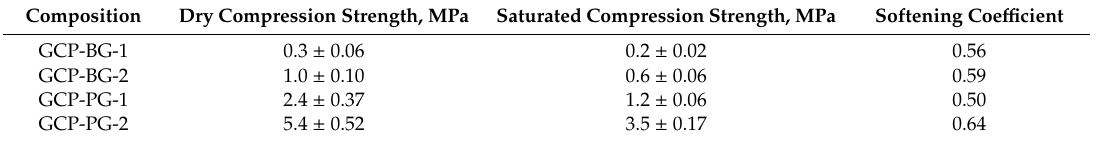
Figure 9. The relation between bulk density and thermal conductivity of foamed ternary system binder. Table 6. Physical properties of foamed ternary system binder.